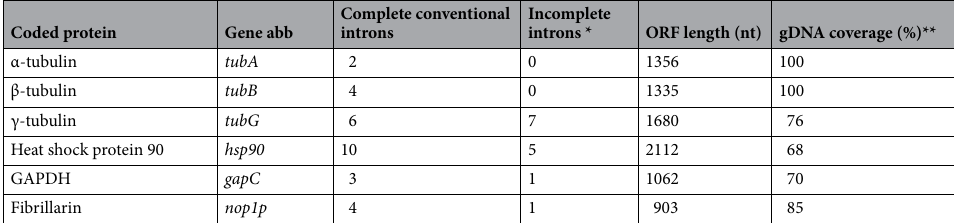
Table 2. Introns identified in selected genes of Rhabdomonas costata. *Only one intron boundary was found in the data, thus the intron type could not be determined with certainty. **Part of ORF length mapped to gDNA. The number of introns may not be definitive in low-percentage